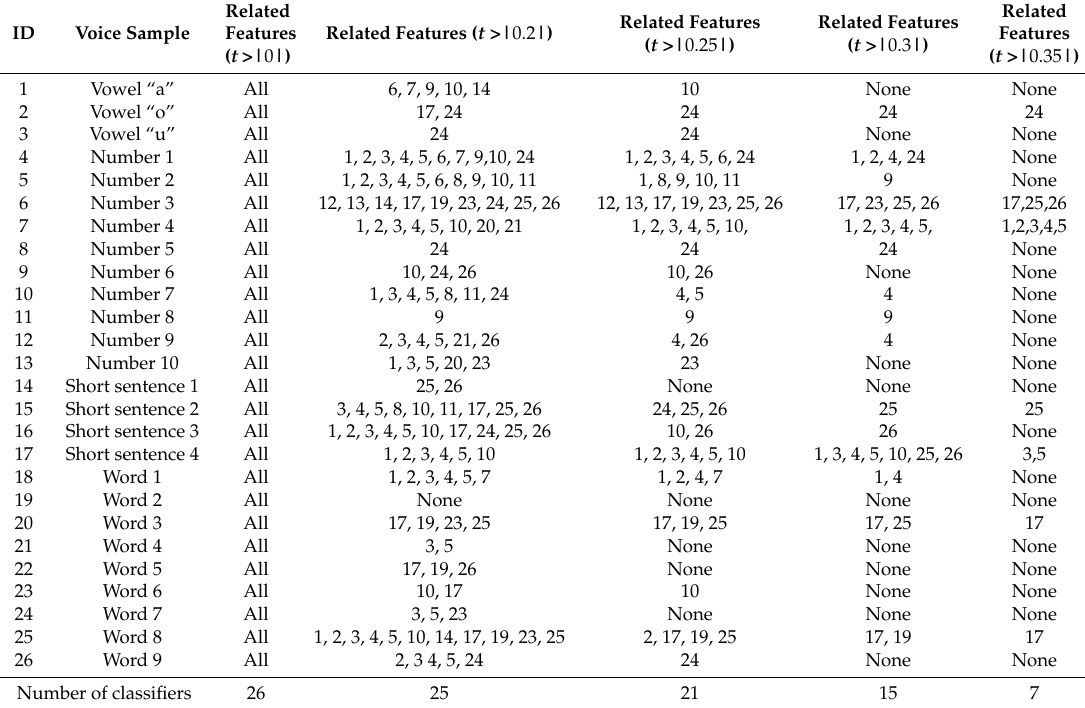
Table 4. Selected time frequency-based features using selected Kendall’s correlation factors in the case of testing multiple ANNs on subject no. 1, and training of ANNs is performed on the other 39 subjects.